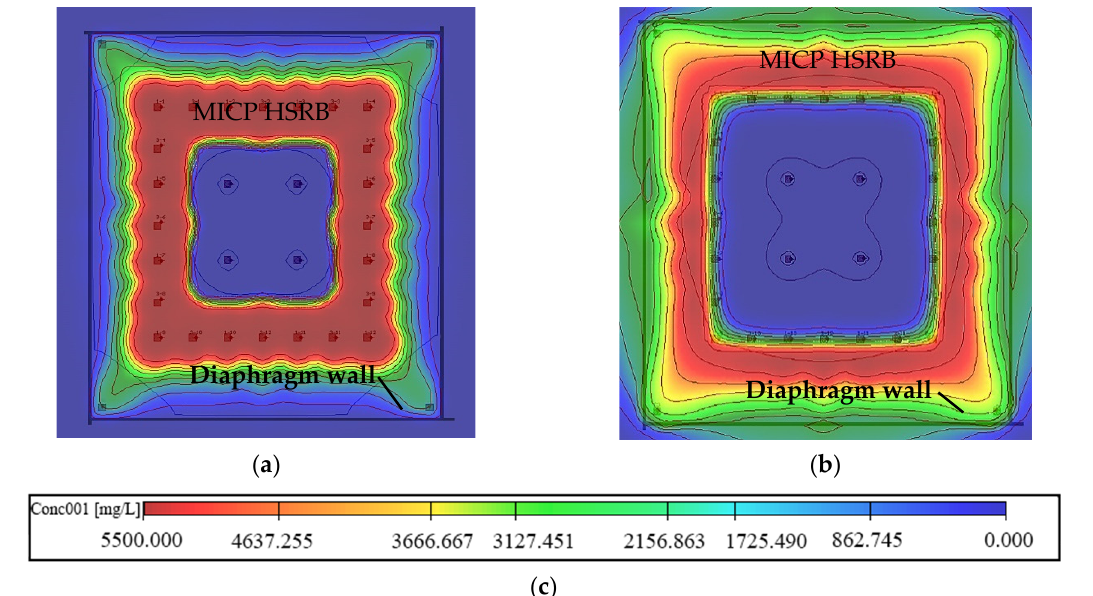
Figure 25. Bacteria migration diagram: ( a ) Horizontal migration map after 1 day of perfusion; ( b ) 1day horizontal migration driven by seepage field after grouting is stopped; ( c ) Legend.